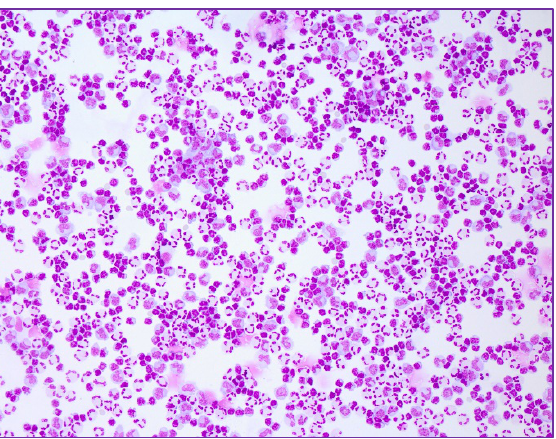
Figure 3. More exacerbated pleocytosis (lymphocytes, monocytes, neutrophils) in the CSF of the 41-year-oldwoman (20× magnification).